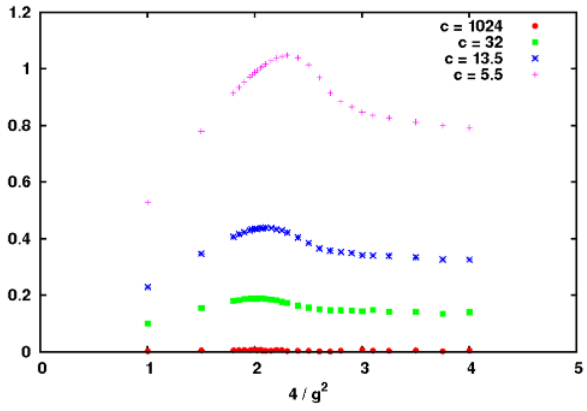
Fig. 4. The action di ff erence, i.e. the first term of expression (15) on a symmetric, 10 4 lattice as a function of the coupling for dif- ferent c values. For c = 1024 the values are practically zero as